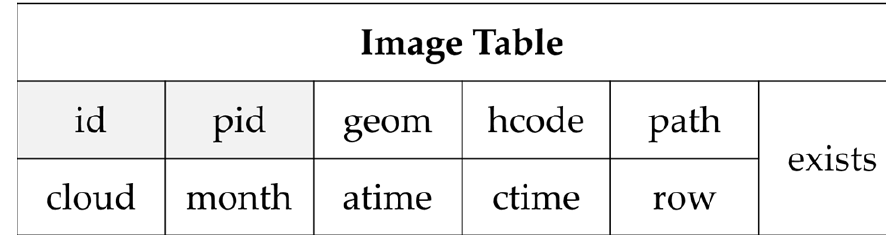
Figure 17. Structure of Product table.